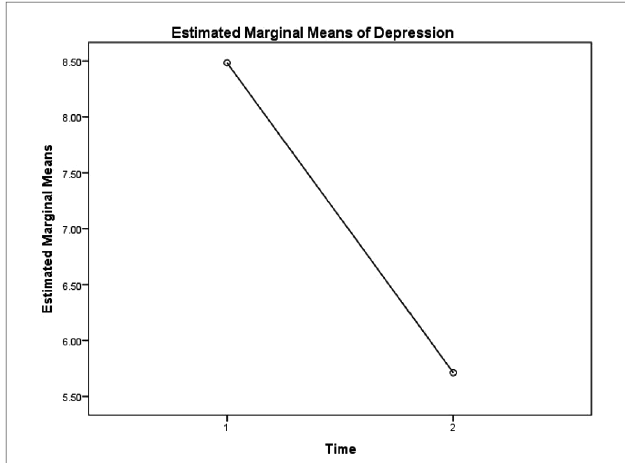
FIGURE 2 Estimated marginal means of depression for participants averaged over